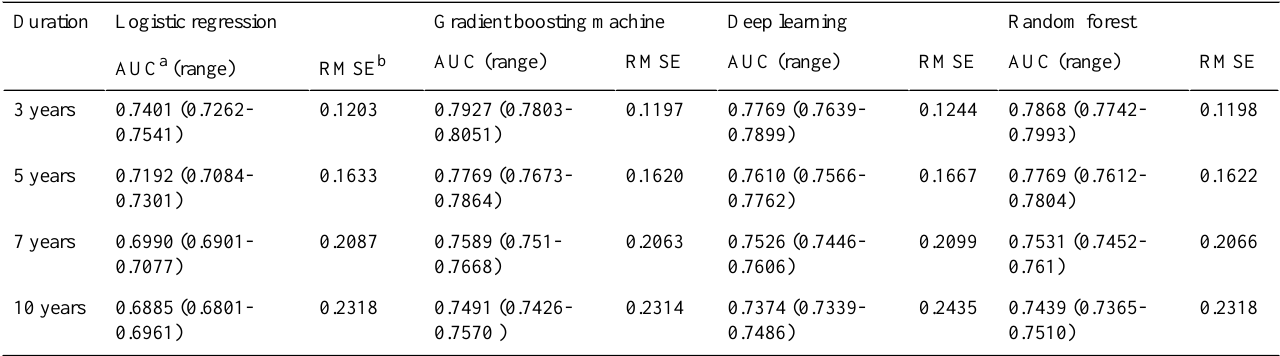
Table 1. Comparison of model performance between logistic regression and machine-learning models.